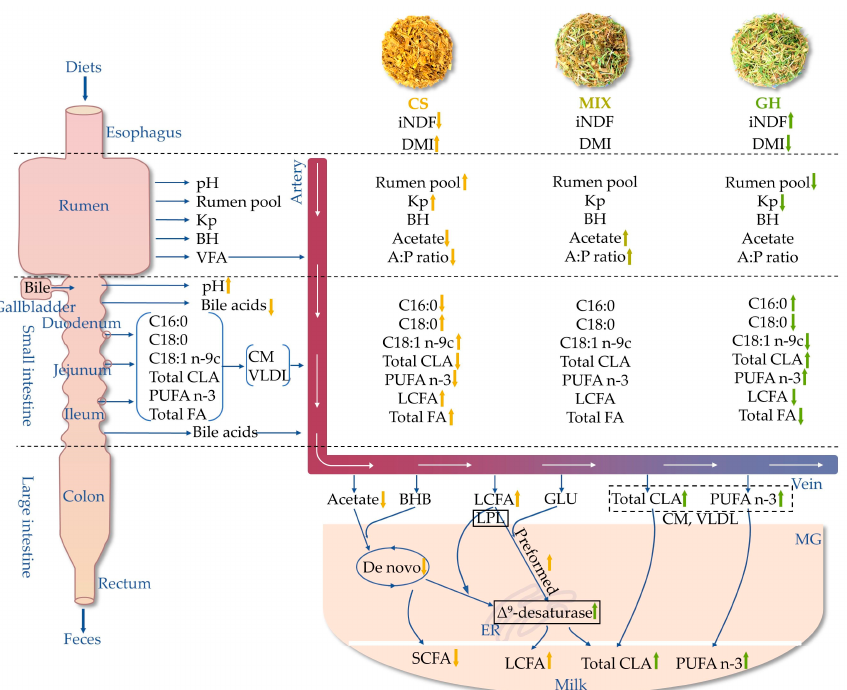
Figure 4. Overall regulatory mechanism of different dietary forage sources regulating health ‐ promoting fatty acid (HPFA) status in milk of lactating cow. iNDF = indigestible neutral detergent fiber, Kp = passage rate out flowing rumen, BH = ruminal biohydrogenation, VFA = volatile fatty acid, A:P ratio = acetate–propionate ratio, Total CLA = total conjugated linoleic acid, n ‐ 3 PUFA = omega ‐ 3 polyunsaturated fatty acid, BHB = β‐ hydroxybutyric acid, CM = chylomicron, VLDL = very ‐ low ‐ density lipoprotein, GLU = glucose, MG = mammary gland, ER = endoplasmic reticulum, LPL = lipoprotein lipase. Enzyme and enzyme activity in the black box denote a key role in HPFA metabolism by the MG. Total CLA and n ‐ 3 PUFA in the dotted box indicate that they are taken up by the MG in the form of CM or VLDL. The arrows indicate the linear or quadratic effects of corn silage proportions on FA metabolism among the three groups, upward and downward arrows denote positive and negative effects ( p < 0.10), respectively.